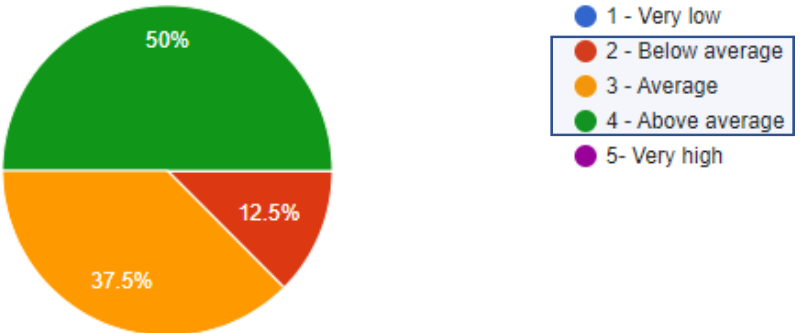
Figure 8. Students’ analysing skills before 2nd smart classroom activity (Subject 2).